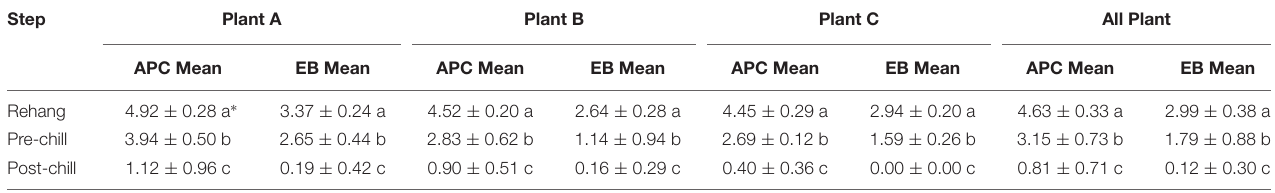
FIGURE 1 | Diagram of the broiler slaughter process. The stars represent sampling locations. TABLE 1 | Microbial log CFU/mL reduction on Whole Bird Carcasses